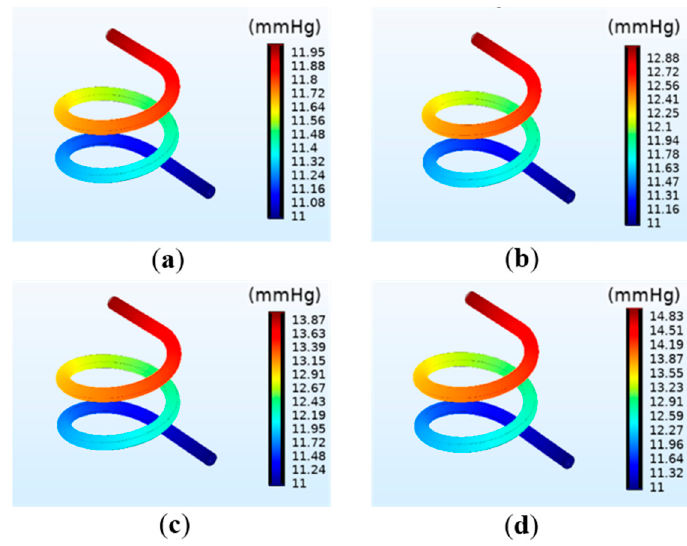
Figure 4. Simulation results of the vascular pressure under different perfusion pressure: ( a ) 12 mmHg; ( b ) 13 mmHg; ( c ) 14 mmHg; ( d ) 15 mmHg.